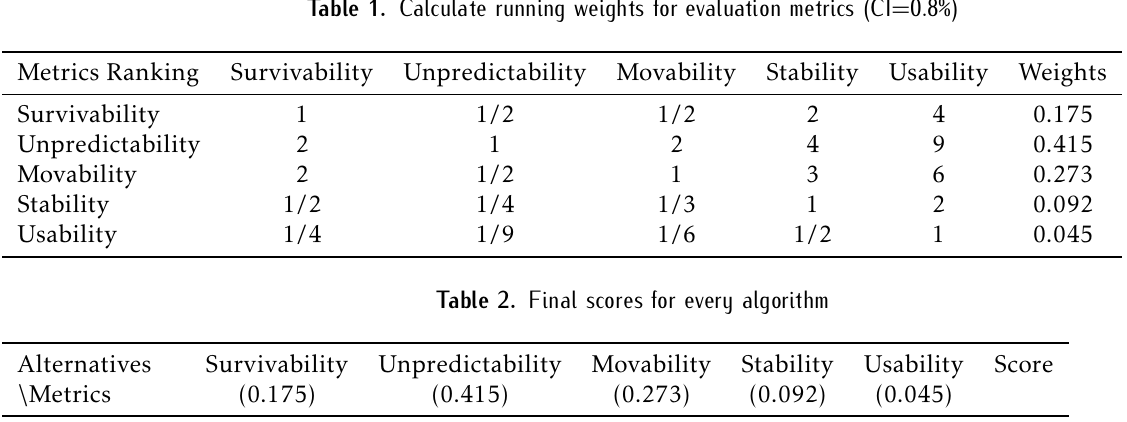
Table 1. Calculate running weights for evaluation metrics (CI=0.8%)